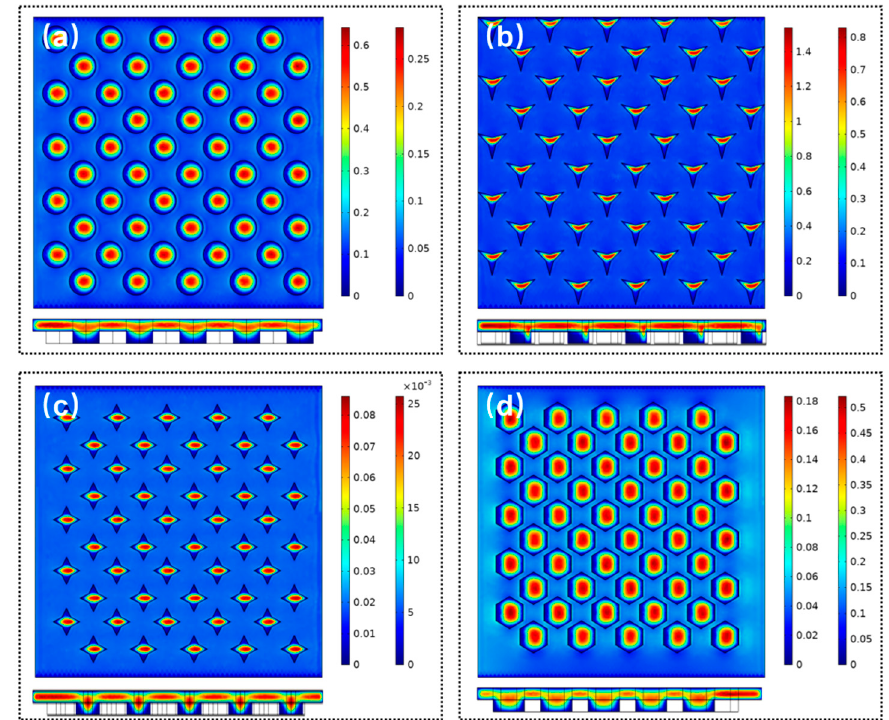
Figure 8. Distribution of the fluid field of different microwell arrays. ( a ) circle, ( b ) triangle star, ( c ) diamond, and ( d ) honeycomb.